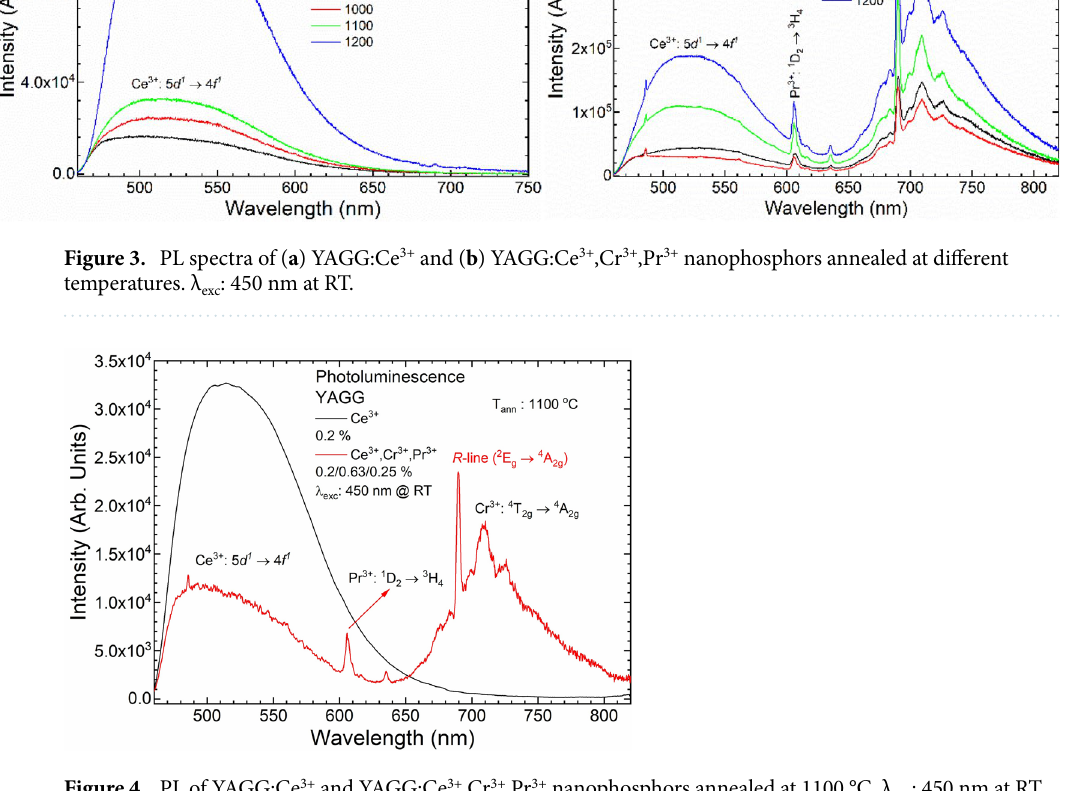
Figure 4. PL of YAGG:Ce 3+ and YAGG:Ce 3+ ,Cr 3+ ,Pr 3+ nanophosphors annealed at 1100 °C. λ exc : 450 nm at